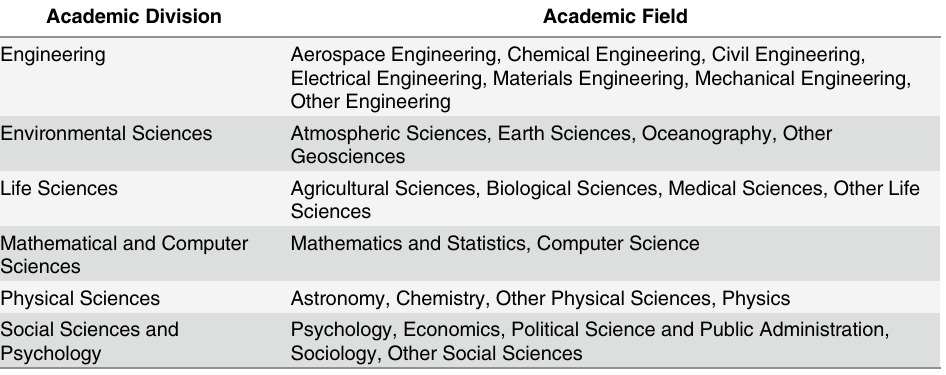
Table 1. Crosswalk between Academic Division and Academic